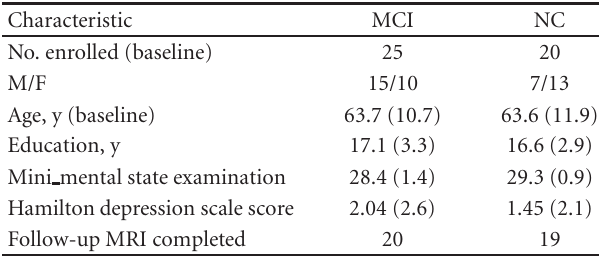
Table 1: Clinical and demographic characteristics of MCI (mild cognitive impairment) and NC (normal control) subjects. Scores are listed as mean (standard